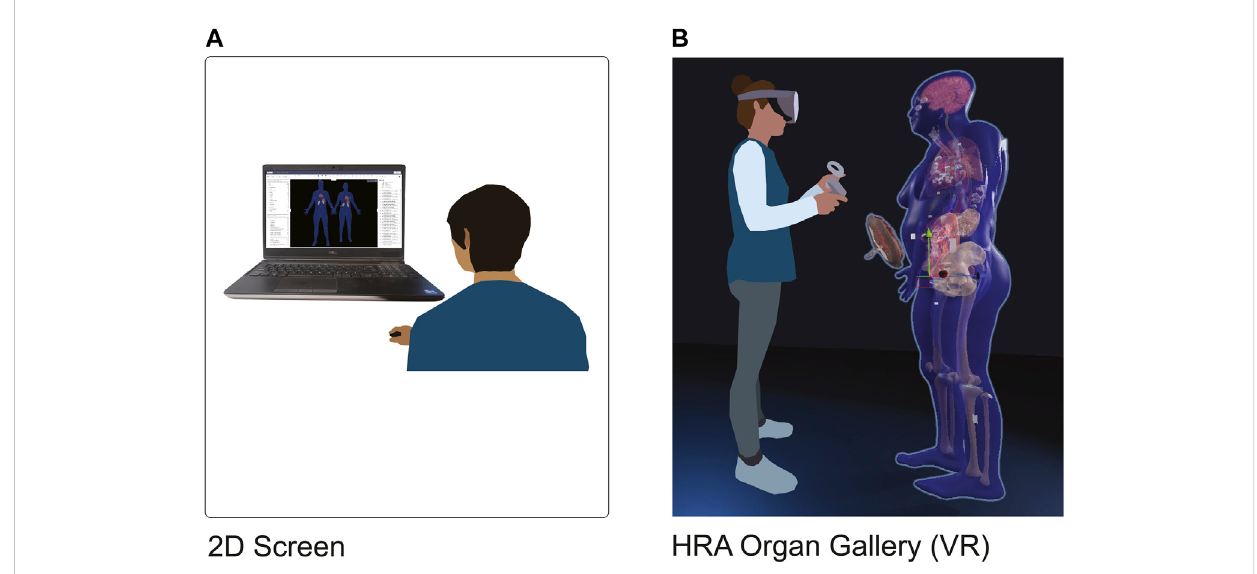
FIGURE 1 2Dvs.VR. (A) :AuserlooksattheHRAwiththeExplorationUserInterface(https://portal.hubmapconsortium.org/ccf-eui)inastandard-sizebrowser windowona17-indisplay. (B) :TheHRAOrganGalleryallowstheusertoviewtheorgans,tissueblocks,andcelltypecountsoftheHRAintruescaleusing immersive technology